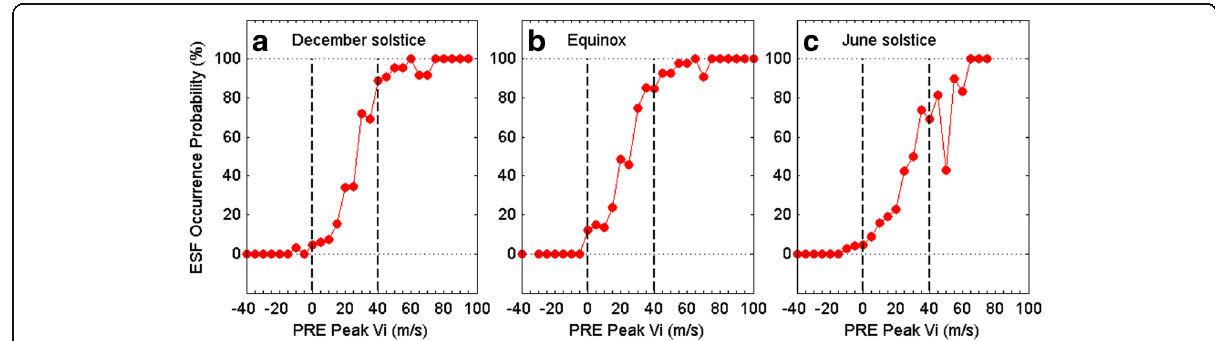
Fig. 8 The dependence of the plasma bubble occurrence probability on the vertical ion drift at the PRE peak measured by C/NOFS during May 2008 – June 2013 for different seasons ( a , b , c